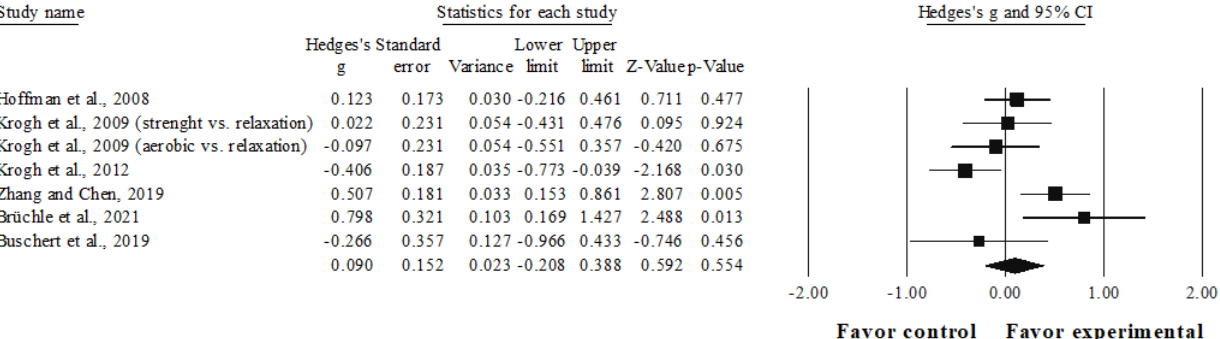
Figure 4. Forest plot for cognitive flexibility outcome. Values shown are effect sizes (Hedges’s g) with 95% confidence intervals. The size of the plotted squares reflects the statistical weight of the study. Black squares: individual studies. Black rhomboid: summary result.